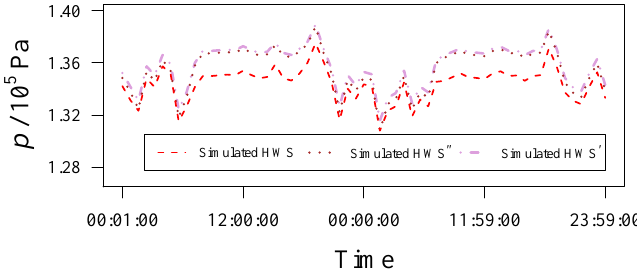
Figure 12. Inlet and outlet pressures of the tee split vs. time. The simulated values were obtained by means of the input signals specified in Figure 8.